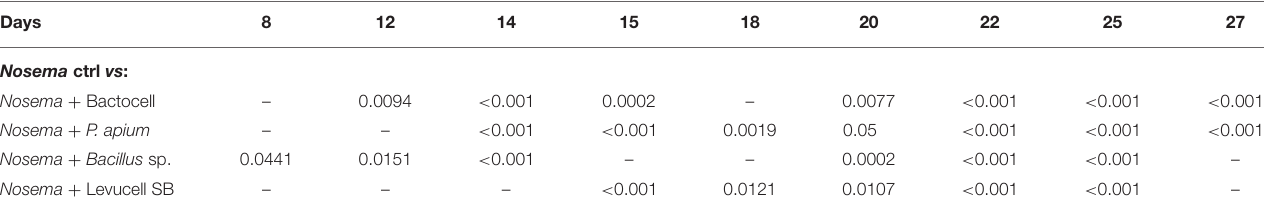
TABLE 6 | Cox Proportional Hazard model (Cox-model) comparisons between survival of the artificial Nosema infection groups ( Nosema ctrl) and experimental groups with curative administration of tested probiotics during the 27 days experiment.